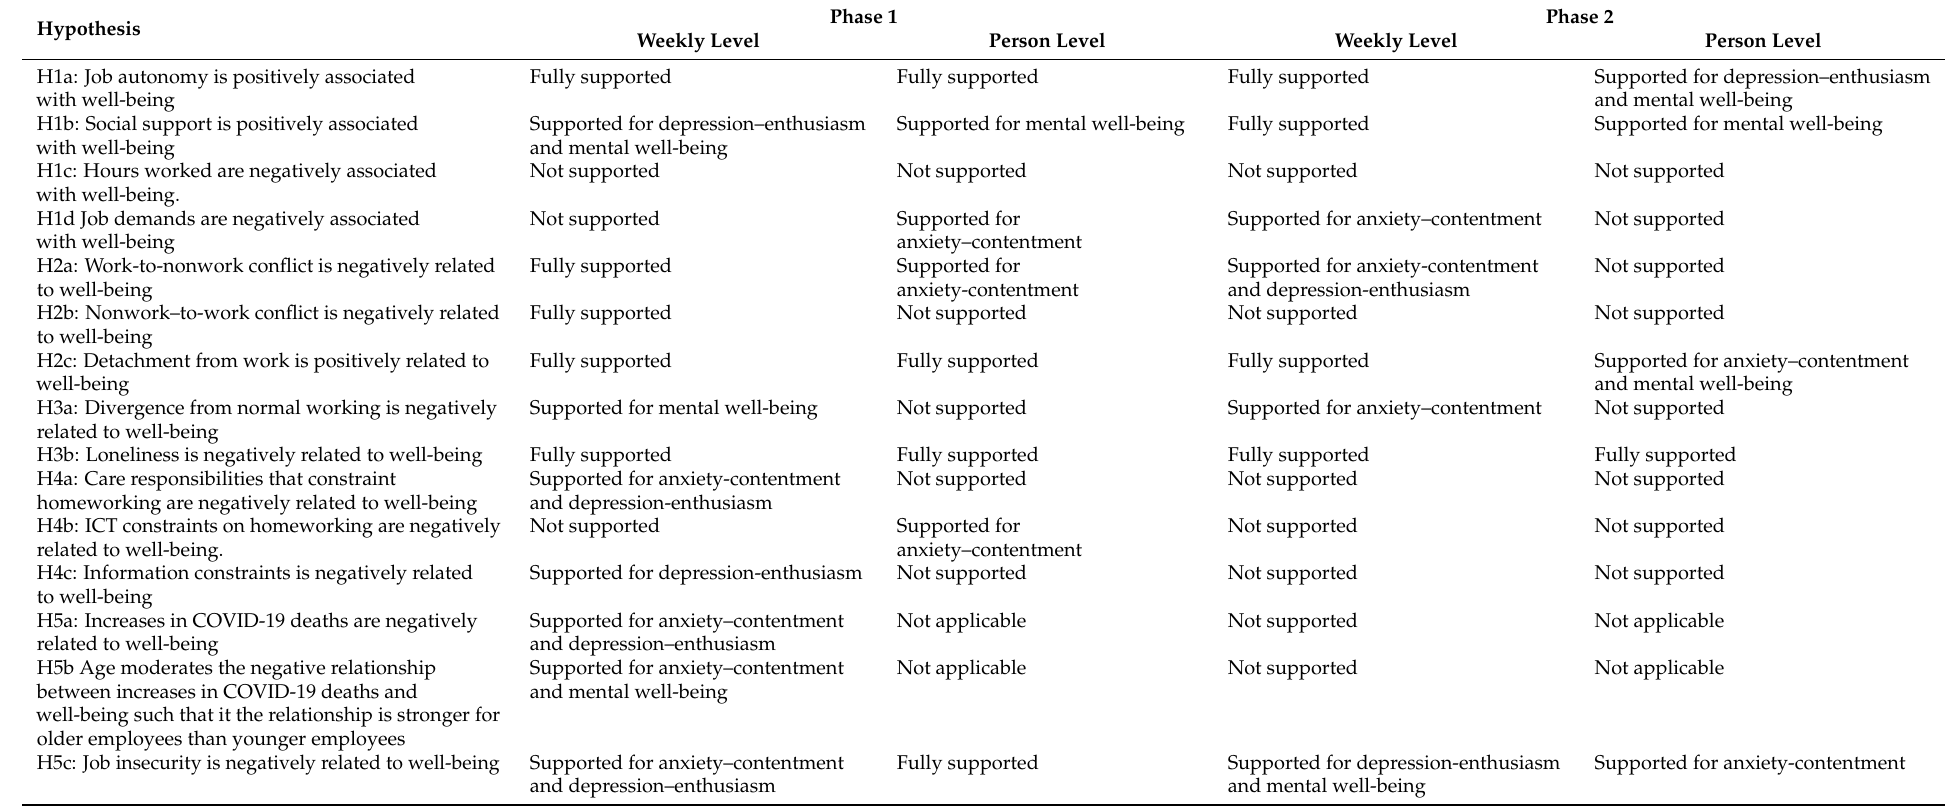
Table 8. Summary of hypotheses and